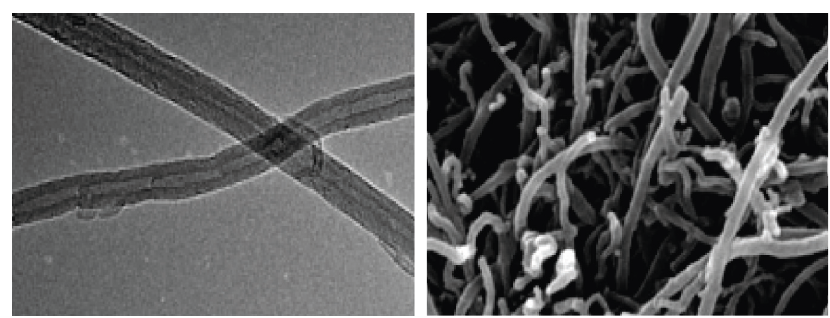
Figure 5: Microscope schematic of carbon